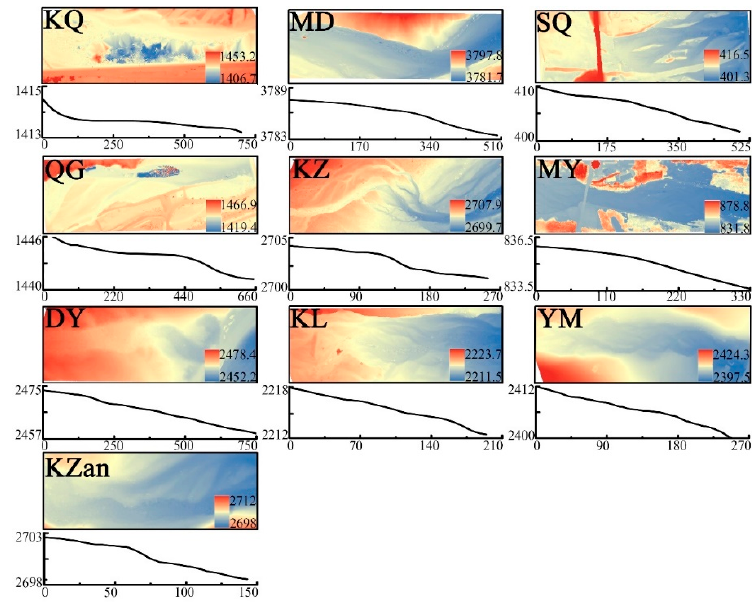
Figure 5. Vertical sections of the ten river sections. The upper part of the picture is DSM and the lower is the shape of the vertical section. The abscissa is the distance (m) and the ordinate is the elevation